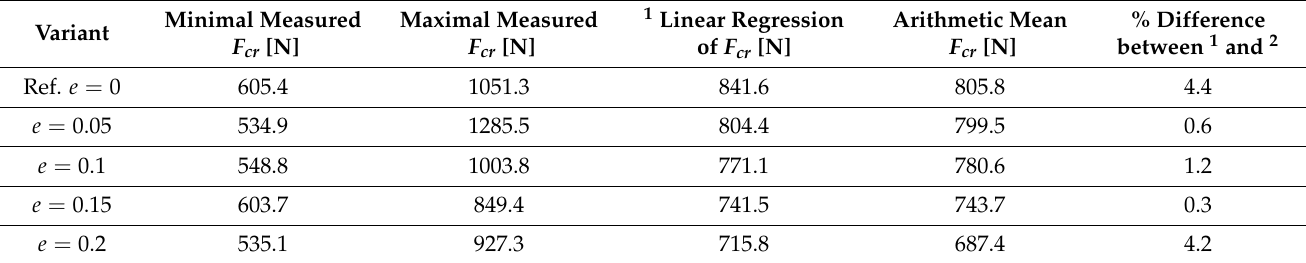
Table 7. Processed values of the determined critical force by experimental measurement.